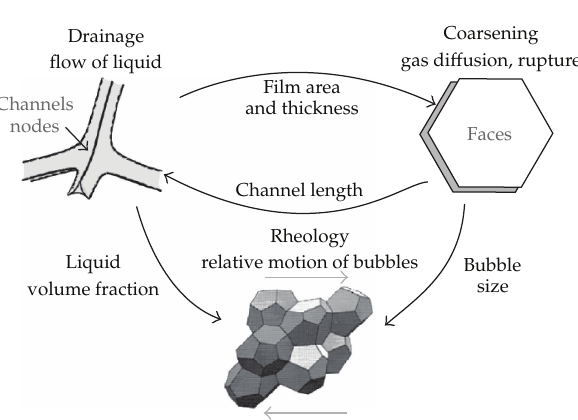
Figure 1: Schematic illustration of the interdependence of drainage, coarsening, and rheology of foams (cid:6) 31 (cid:7) .